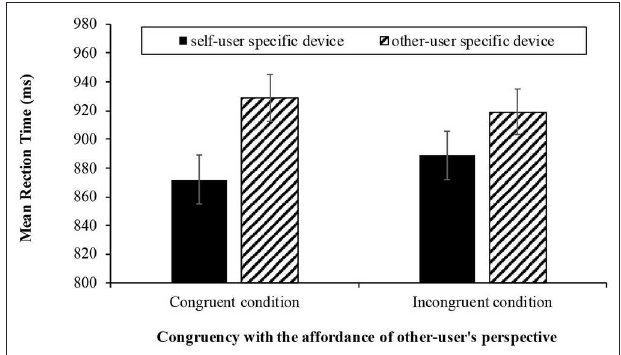
FIGURE 2 | The results of mean reaction time ( ± SE ) it took to categorize the smart home device words accurately as the congruency between affordance of the other user’s perspective and the word (2: congruent, incongruent) and the primary user-specific devices (2: self, other) in Experiment